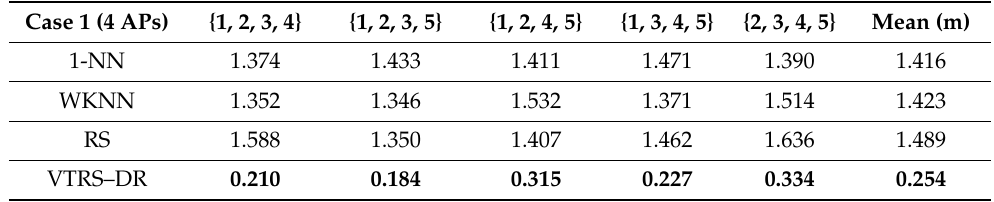
Table 8. Mean errors of using four APs in Case 1.